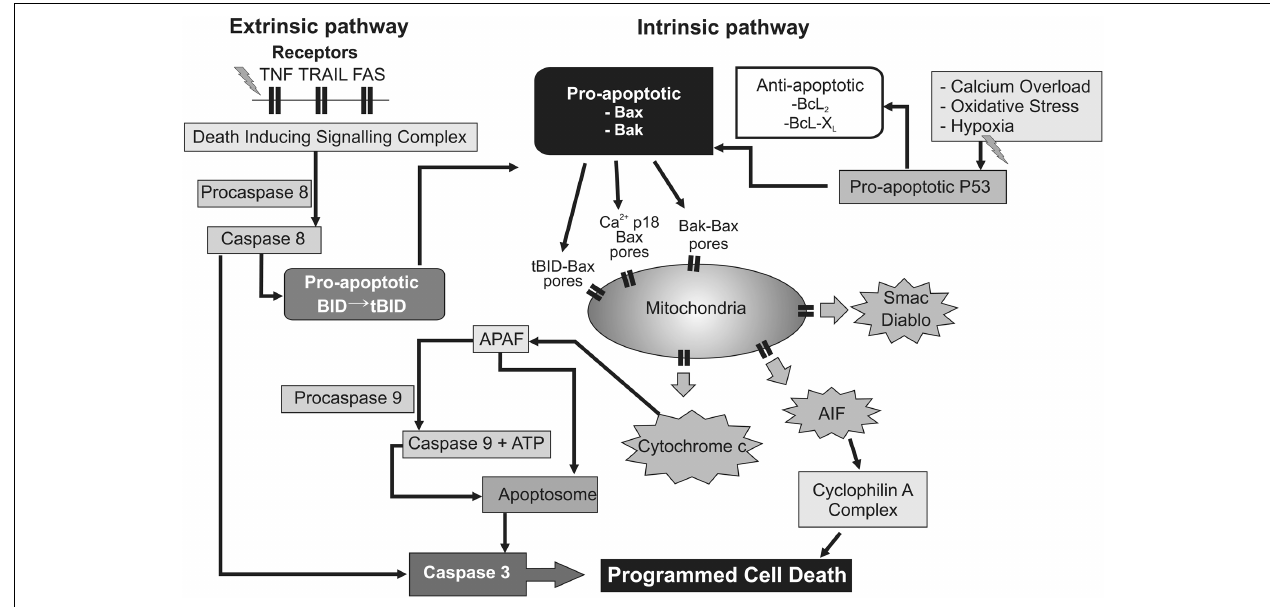
FIGURE 3 | Flow chart depicting several intracellular mechanisms associated with permeabilization of the mitochondrial membranes, leading to progressive failure of mitochondrial oxidative phosphorylation and ultimately delayed programmed cell death. Upstream triggers such as inflammation and trophic withdrawal activate cell surface death receptors initiating the “extrinsic” pathway to programmed cell death. Conversely, calcium overload and oxygen free radicals appear to exert their effect predominantly at the mitochondrial level via the “intrinsic” pathway. In addition, cross-over activation between the “extrinsic” and “intrinsic” pathway may take place through